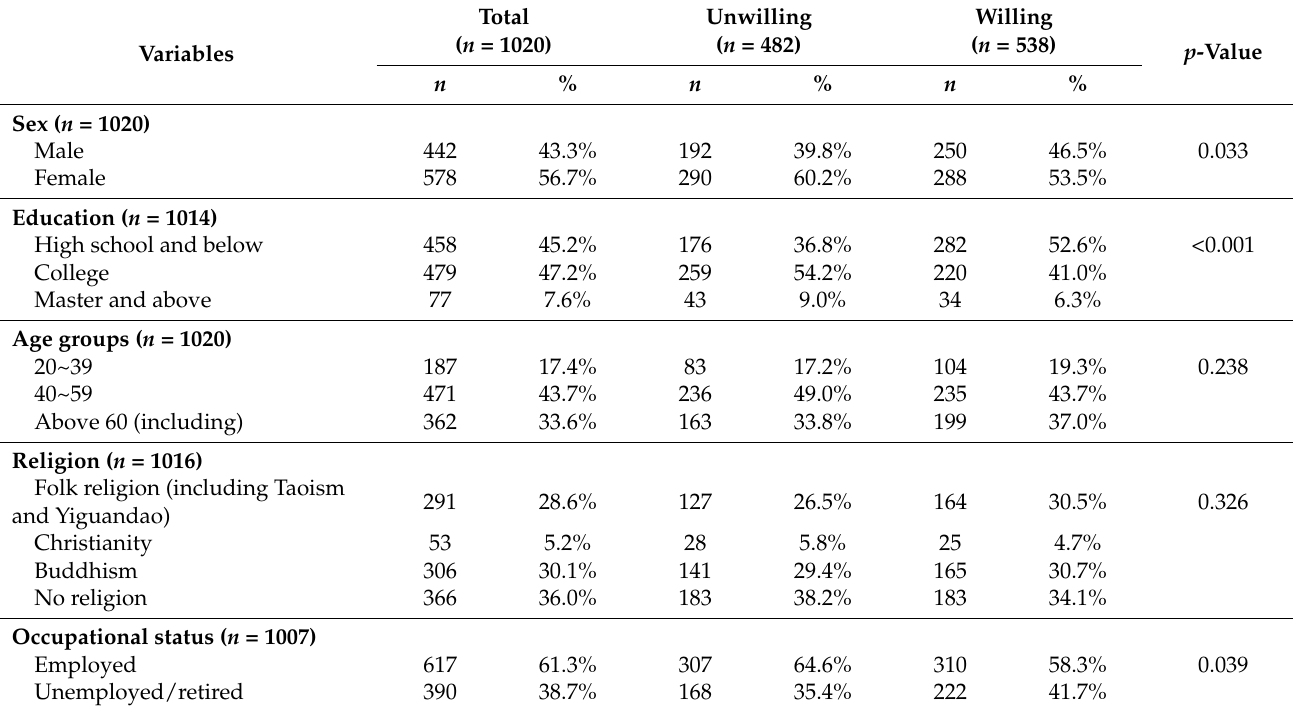
Table 1. Basic demographic characteristics affecting COVID-19 vaccine uptake intention.